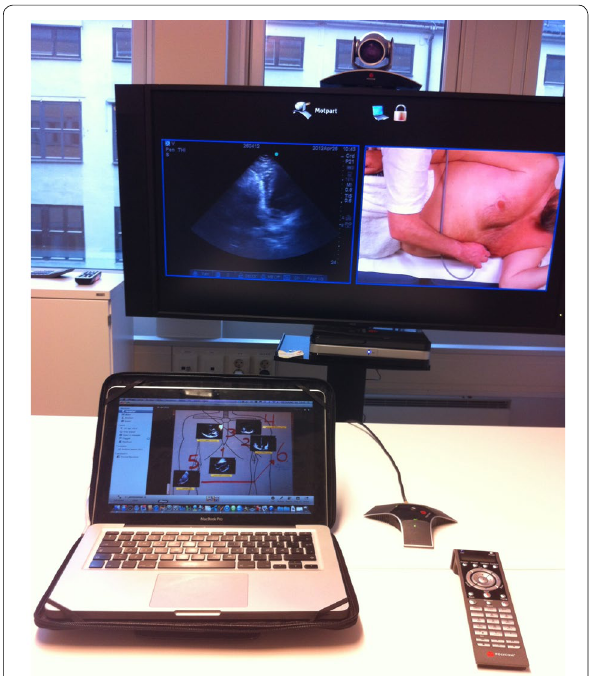
Fig. 2 Onshore computer showing the split screen with both the ultrasound image and roof camera video. Photo: Nils Petter Oveland